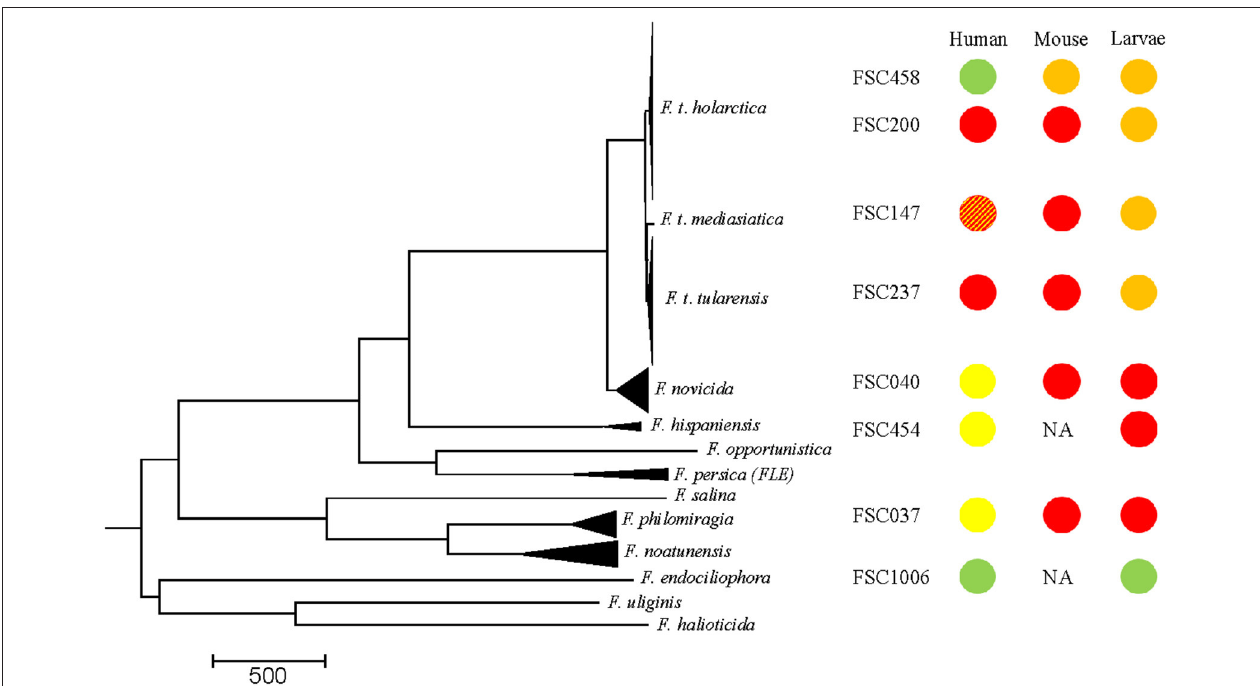
FIGURE 4 | Comparison between data of Francisella spp. lethality in G. mellonella generated in this study and previously published data on Francisella spp. lethality in mice by subcutaneous or intracutaneous inoculation ( Bell et al., 1955; Owen et al., 1964; Gury ˇ cová, 1998; Kieffer et al., 2003; Salomonsson et al., 2009; Molins et al., 2014; Propst et al., 2016; Timofeev et al., 2017 ) and severity of disease in humans (Saslaw et al., 1961a,b; Dienst, 1963; Kugeler et al., 2009). Lethality of the different Francisella strains in G. mellonella (larvae death within 3 days, infectious dose 10 6 bacteria/mL) and mice (LD 50 < 10 3 ) was scored as high lethality (red), intermediate lethality (larvae death > 3 days, LD 50 mice > 10 3 ) (orange) and non-lethal (green). Severity of disease caused by the Francisella strains in humans, was scored as incapacitating disease in humans (red), causing disease only in humans with a compromised immune response or underlying health defects (yellow) and non-virulent (green). There is only limited data on the virulence of F. t. mediasiatica in humans ( Timofeev et al., 2017) (striped) and data on F. hispaniensis and F. endociliophora lethality in mice are lacking. The LVS strain is a live attenuated strain that was selected for vaccination in humans but still remains unlicensed for human use (Sandström, 1994). NA, data not